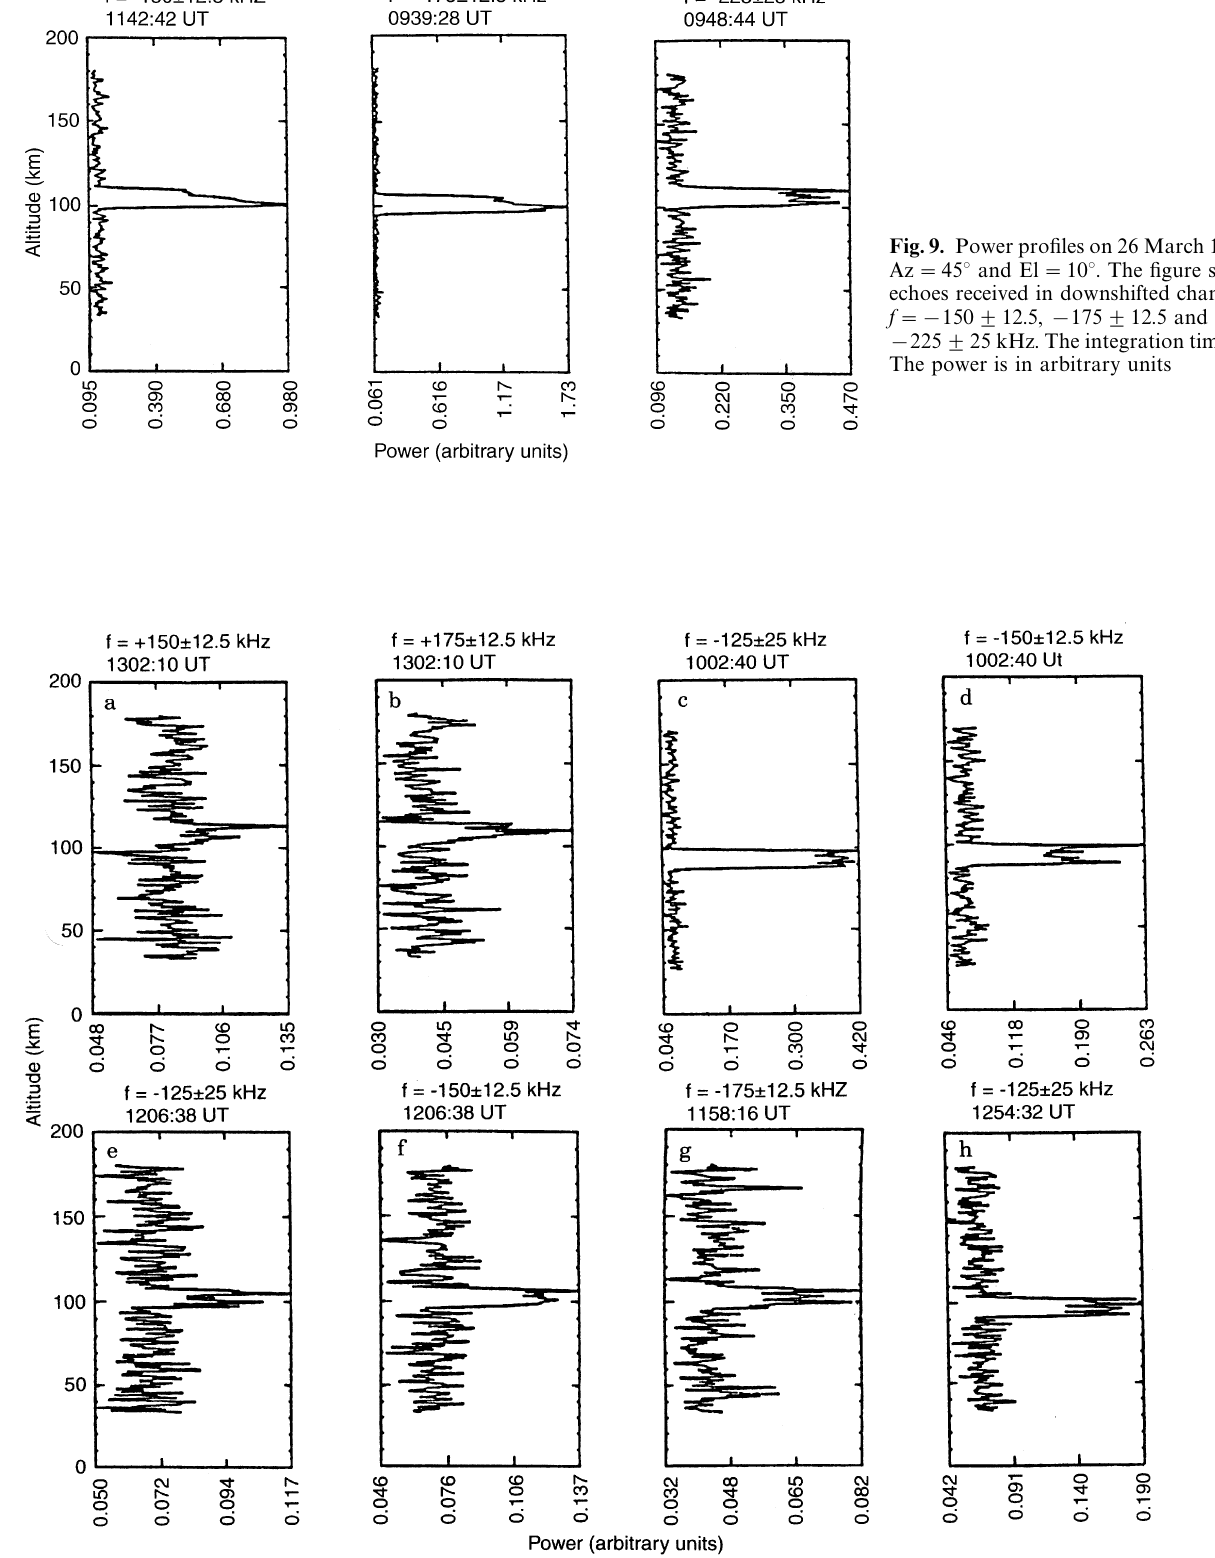
! 150 $ 12.5 kHz; g and h signals in downshifted channels at f "! 175 $ 12.5 and ! 125 $ 25 kHz. The integration time is 2 s in all panels. The power is in